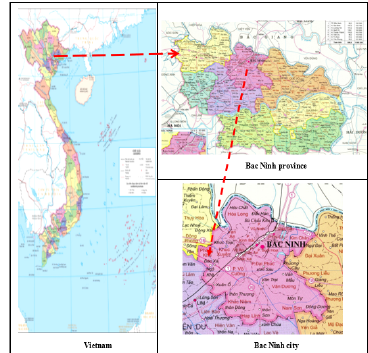
Fig. 1. Geographical location map of Bac Ninh city, Bac Ninh province